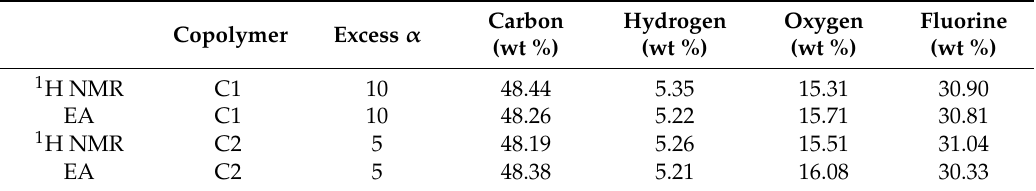
Table 6. Comparison between the elemental compositions calculated based on magnetic resonance ( 1 H-NMR) and measured by elemental analysis (EA).